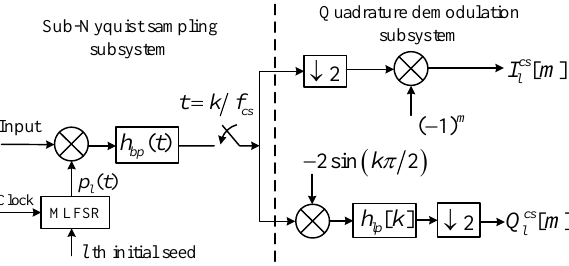
Figure 1. The architecture of QuadCS. The first subsystem is to perform low-rate random measurement; the second subsystem is a classical digital quadrature demodulation system [20] used for extract compressive in-phase and quadrature